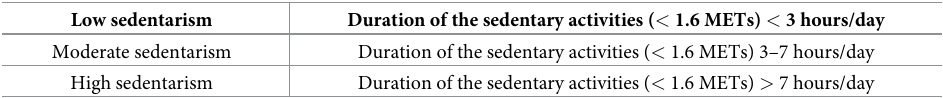
Table 2. Levels of sedentarism (based on the number of hours spent daily on sedentary activities ( < 1.6 METs)) from the French national observatory for physical activity and Sedentary Behaviours